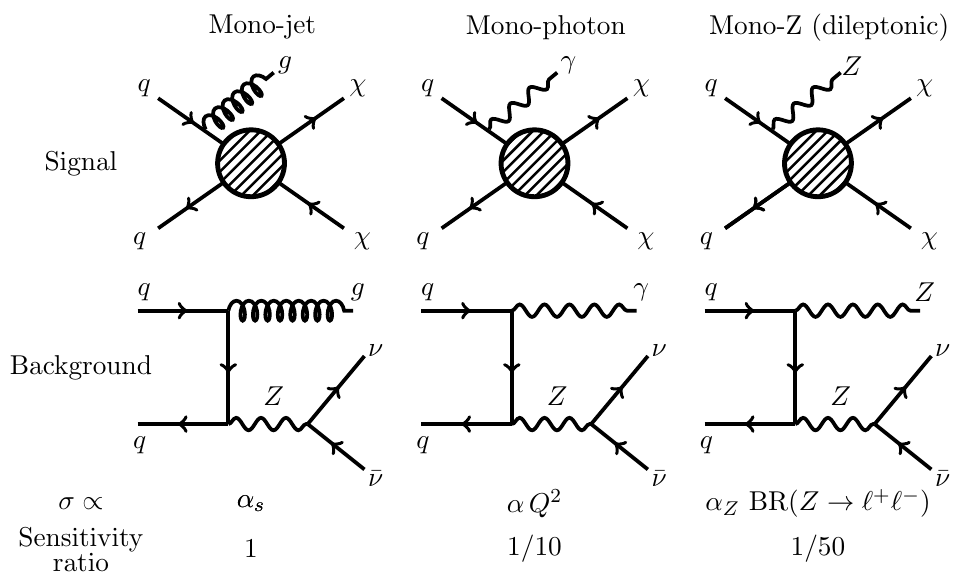
Figure 1 . Relative signal sensitivity in three main mono- X channels. Since the cross sections for each signal and its irreducible background scale in the same way, if we assume the relative e(cid:14)ency for the signal and background processes are the same over each of the di(cid:11)erent channels, the naive relative signi(cid:12)cance, computed as S= this argument does not account for systematic uncertainties, which we expect will grow at higher centre-of-mass